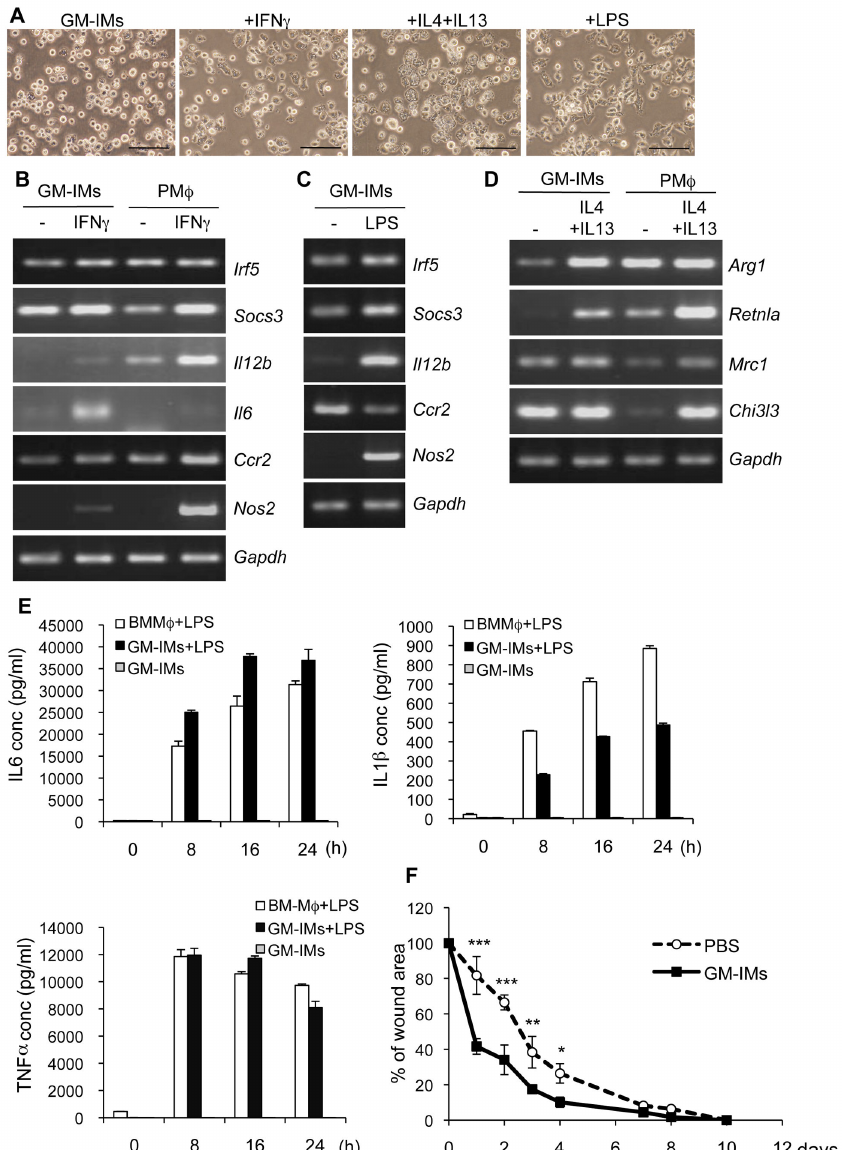
Figure 6. Potentials of GM-IMs to differentiate to M1 or M2 macrophages. GM-IMs or PMφ were stimulated with 20 ng/mL IFNγ, 20 ng/mL IL-4 and 20 ng/mL IL-13 or ong µg/mL LPS for 24 hr. (A) Phase contrast photographs of GM-IMs after stimulation. Scale Bar: 100 µm. (B) After stimulation by IFNγ for 24hr, expression of M1 marker genes was analyzed by RT-PCR. (C) After stimulation by LPS, RNA was extracted and expression of M1 marker genes was analyzed by RT-PCR. (D) After stimulation by IL-4 and IL-13, expression of M2 marker genes was analyzed by RT-PCR. (E) GM-IMs or BMMφ (1 x 10 6 ) were cultured in six-well plastic plates with RPMI-1640 containing 10% FBS and 3% GM-CSF-CM. They were stimulated with one µg/mL LPS for indicated times. Supernatants were taken and cytokine expression of IL-6, IL-1β or TNFα was analyzed by ELISA. Data shown are the mean ratios ± SE of three separate experiments. (F) The dorsal skin of two-month old female C57BL/6 mice (n=4) was punctured through two layers of skin with a sterile disposable three mm biopsy punch (Kai Industries). GM-IMs (3 x 10 4 ) were directly injected into each wound on the right side. PBS was dropped on the other side as a control. The changes in the percentages of wound areas at each time point were compared to the initial wound area. Data shown are the mean ratios ± SE of three independent experiments. P value: * < 0.05, **<0.01, ***<0.001, GM-IMs injected area versus PBS injected area. Data are representative of three independent experiments with similar results (A-D). doi: